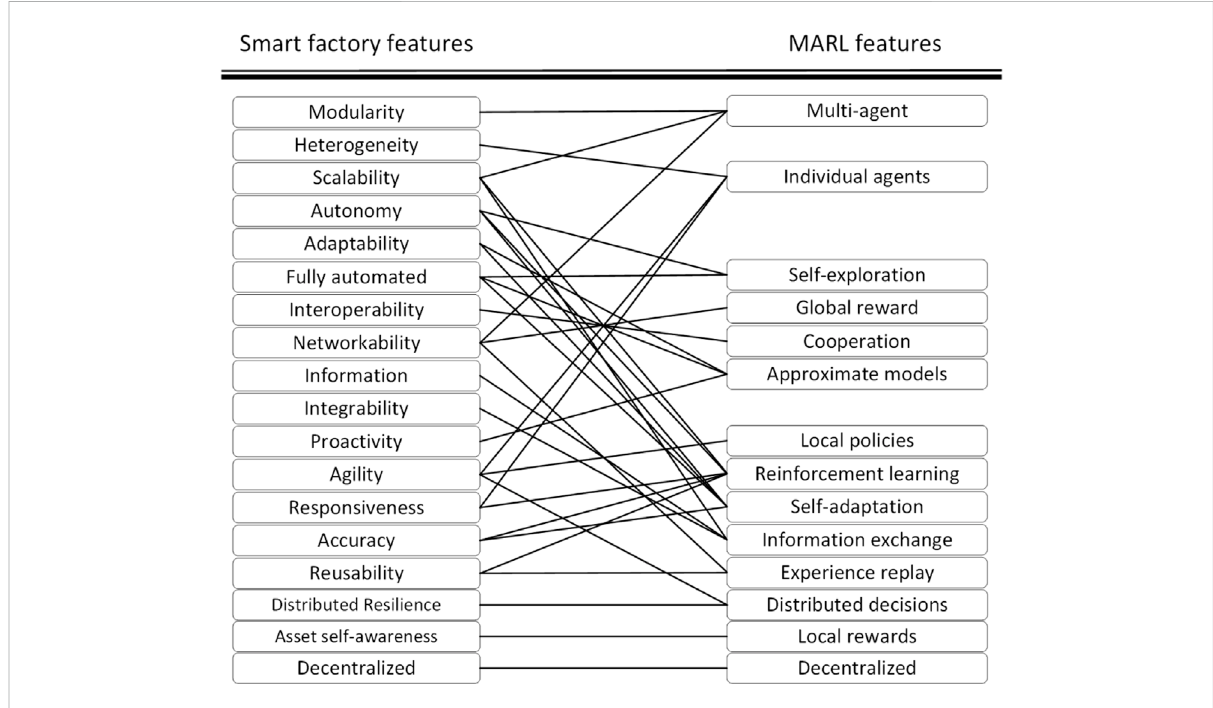
FIGURE 9 Matching between smart factory features and MARL